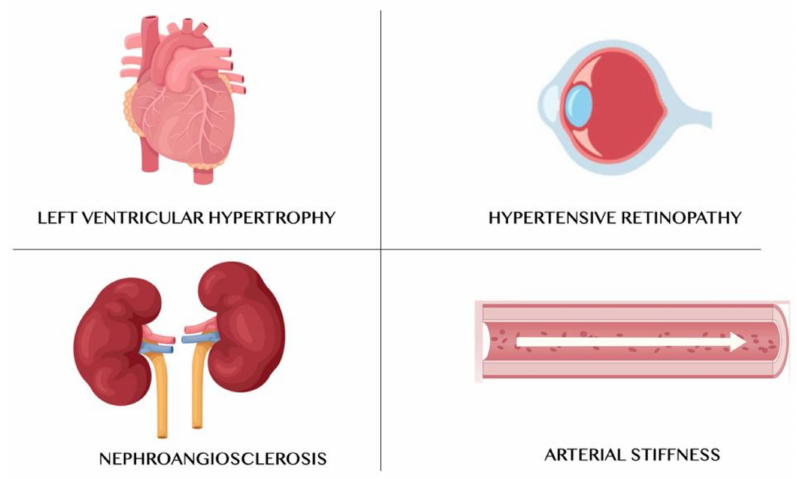
Figure 1. Main target organs of arterial